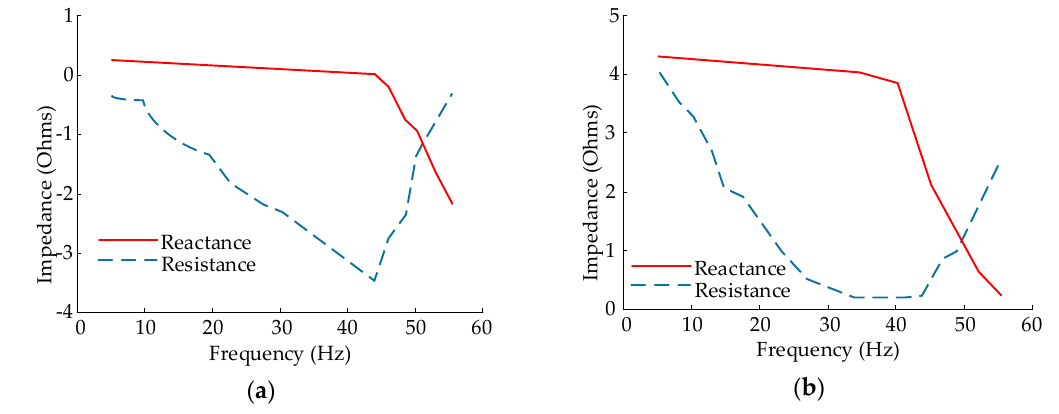
Figure 5. Turbine side scans of wind park: ( a ) with PI controller; ( b ) with EFL controller.